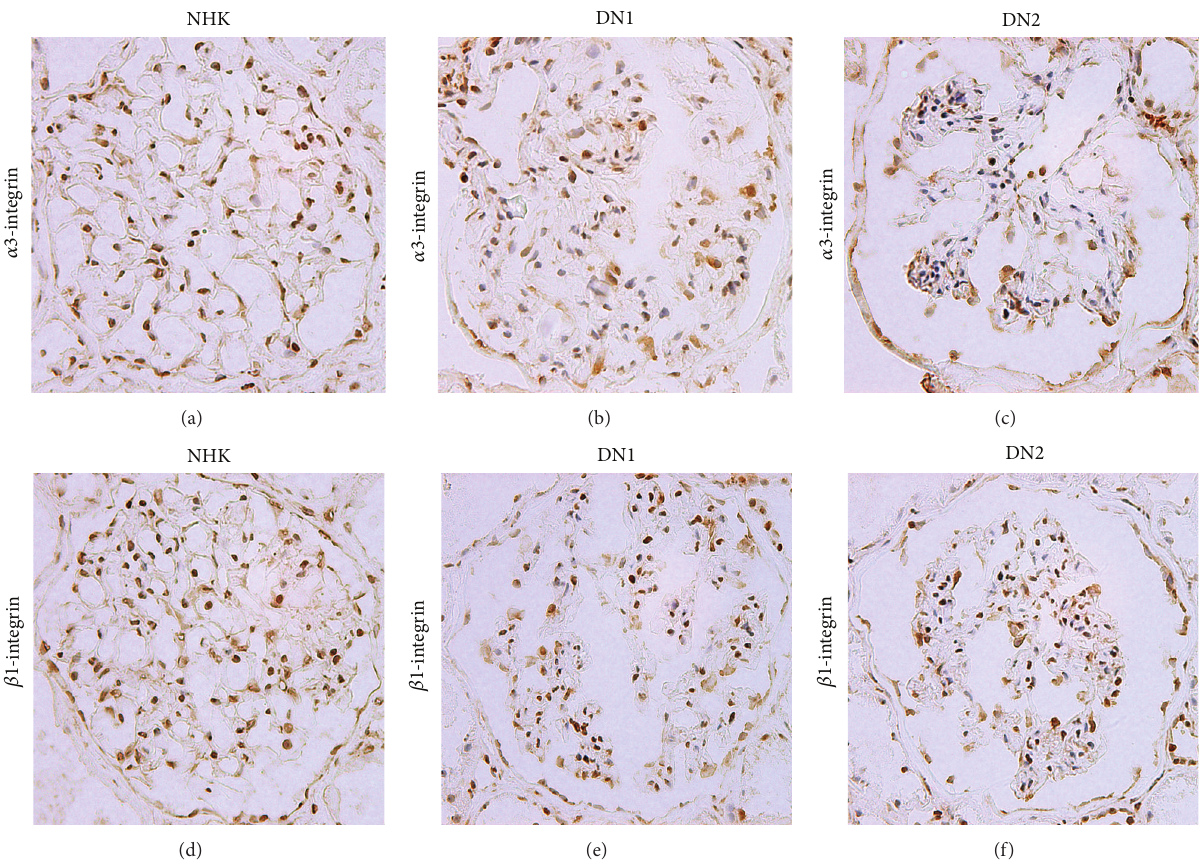
Figure 1: In situ hybridization of 𝛼 3- and 𝛽 1-integrin subunits. Representative mRNA expression of integrin subunits in glomeruli of normal human kidney, early (DN1) and advanced (DN2) stages of DN. Integrin expression is colored by DAB (brown), and nuclei of cells are stained by hematoxylin (blue) (magnification, × 100).